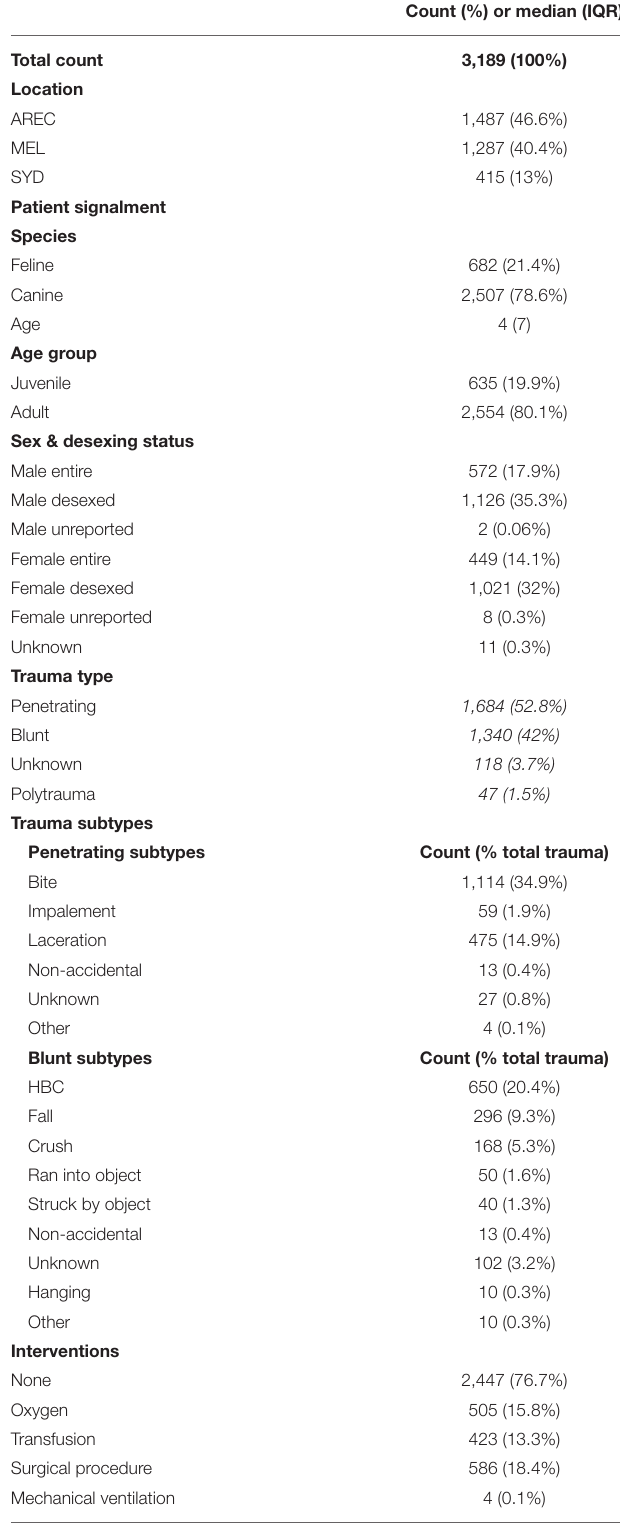
TABLE 1 | Patient characteristics, interventions, and outcomes over the 3-year study